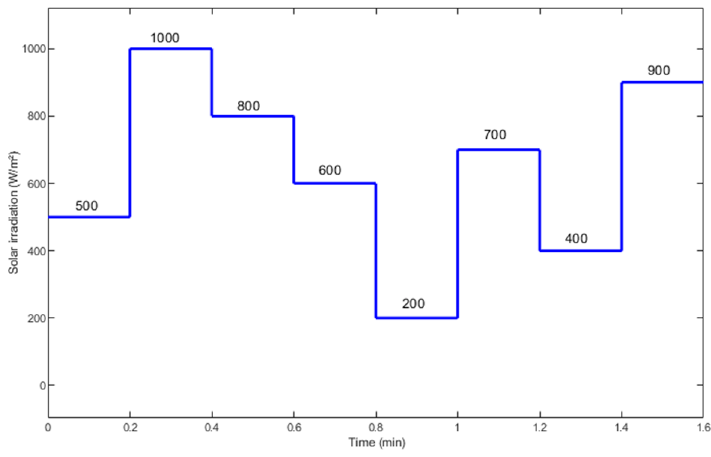
Figure 11. Solar irradiation.